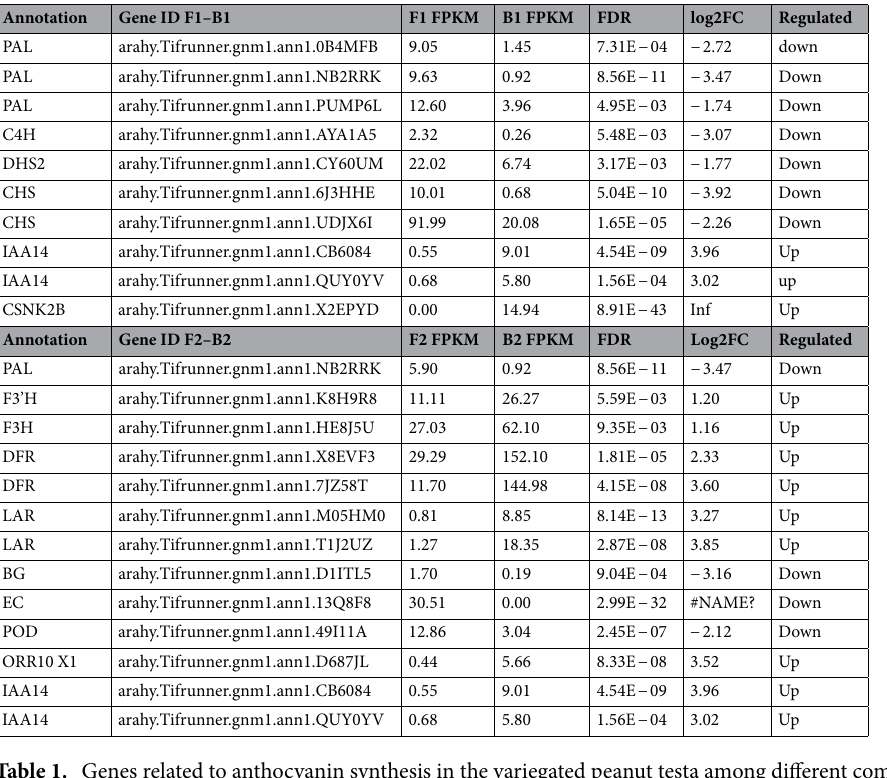
Table 1. Genes related to anthocyanin synthesis in the variegated peanut testa among different comparison groups.